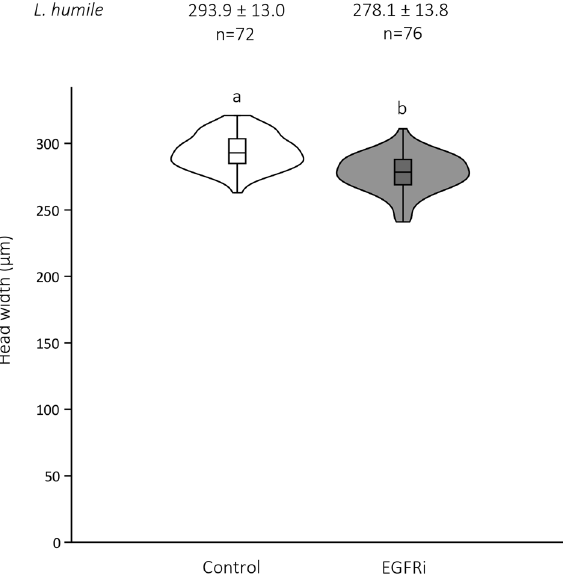
Figure 5. Effect of EGFRi treatment on worker head width. Violin plots of the head widths of Linepithema humile callows. Workers came out of two groups: larvae fed a control solution (1 M sucrose [diluted in DMSO]) versus larvae fed EGFRi (diluted in DMSO) during the first-instar stage. Mean head width ± SD and sample size are indicated above each plot. The box’s midline indicates the median; the box’s lower and upper edges are the first and third quartiles, respectively. The whiskers reflect the extreme values. The shapes around the boxes are the kernel density distributions of the data. Differences in the letters above the violins indicate statistically significant differences in worker head width (Student’s t test: p <